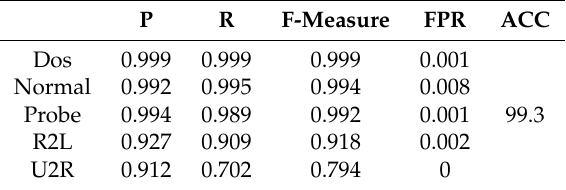
Table 7. Evaluation measures of normal and other types of attacks classification for NSL-KDD